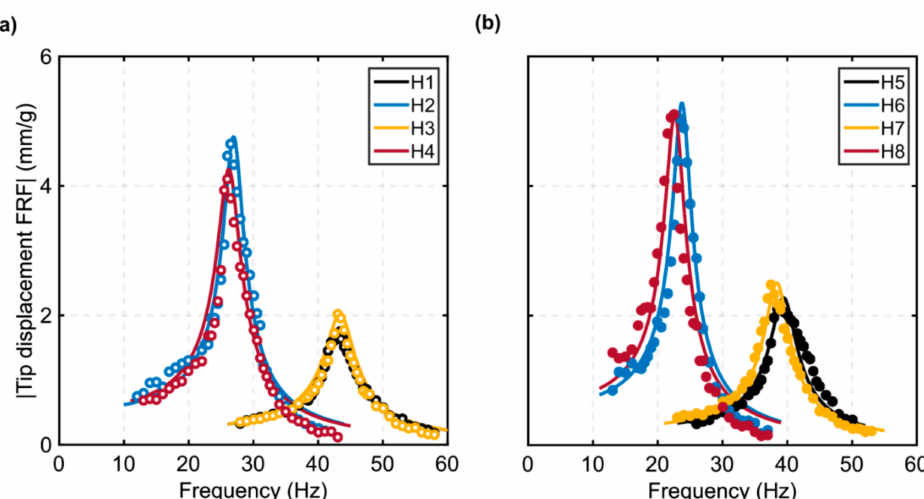
Figure 4. Measured and predicted tip displacement output FRFs for the eight harvesters. ( a ) Harvesters without solar panels (empty circle markers). ( b ) Harvesters with solar panels (filled circle markers). Markers represent the experimental measurements whereas solid lines represent the equivalent concentrated tip mass model